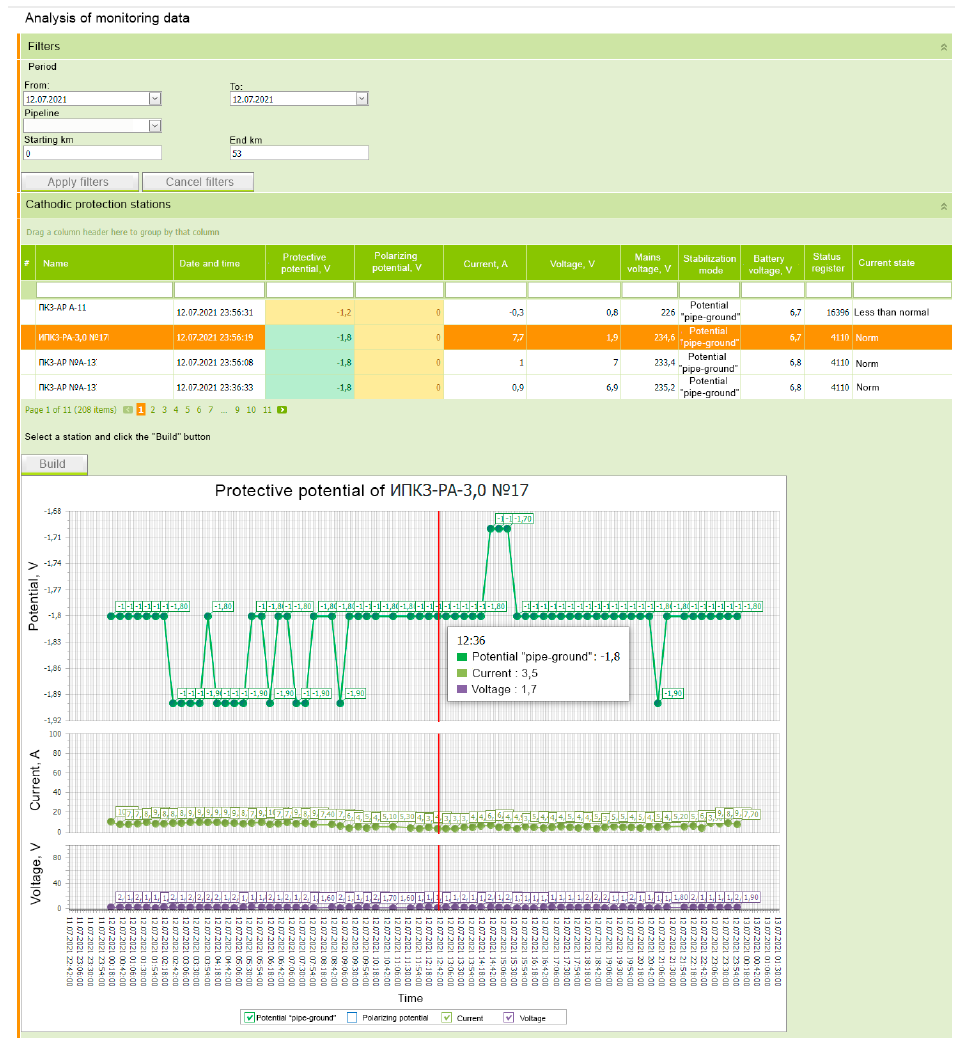
Figure 2. Web interface with the CPS monitoring data.